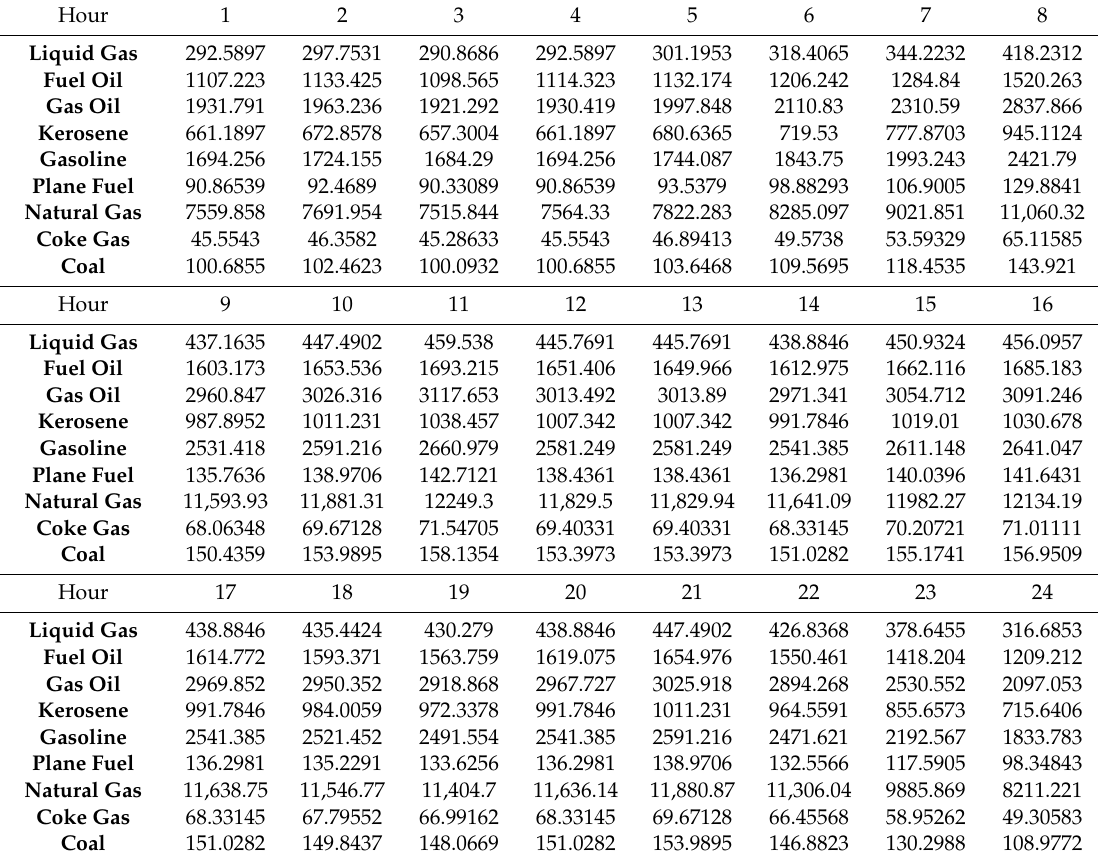
Table 5. The need of energy carriers (BOE).